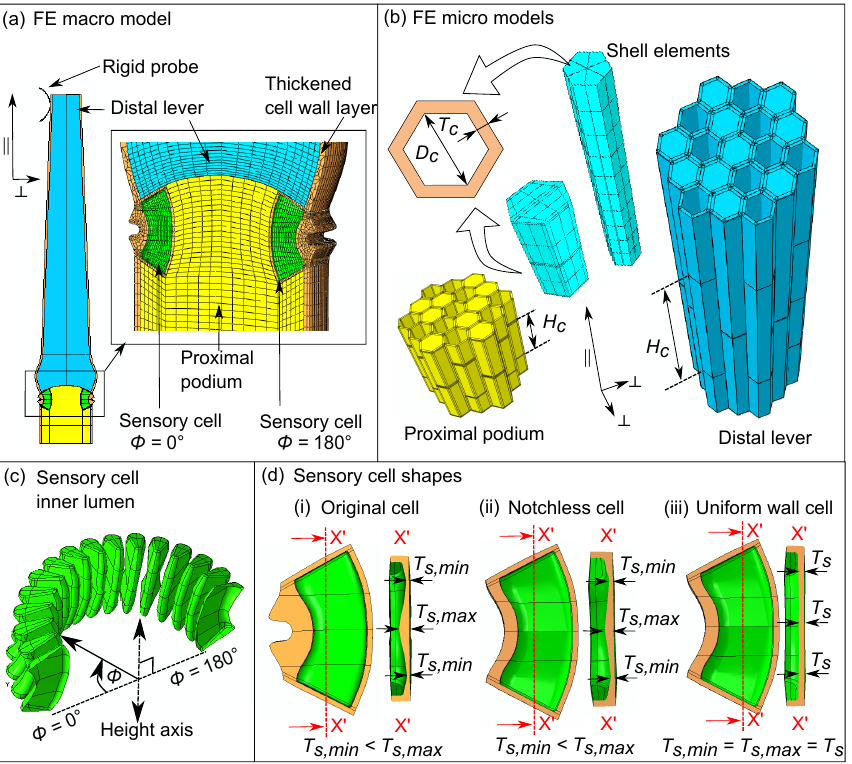
Figure 5. ( a ) Sensory hair half model with lever ( blue ), podium ( yellow ), and sensory cells with their inner lumen ( green ) and cell wall ( beige ). The enlarged image ( right ) shows FEM mesh. ( b ) Tissue micro models with hexagonal cells having a height ( H c ), lumen diameter ( D c ), and wall thickness ( T c ). ( c ) Segmented view of the inner lumina of sensory cells located at polar angle φ ∈ [0, 180], about the height axis. ( d ) Longitudinal section of sensory cells with ( i ) original cell shape and two variants: ( ii ) a notchless cell and ( iii ) a sensory cell with uniform wall thickness. T s , min , max denote cell wall thicknesses at different